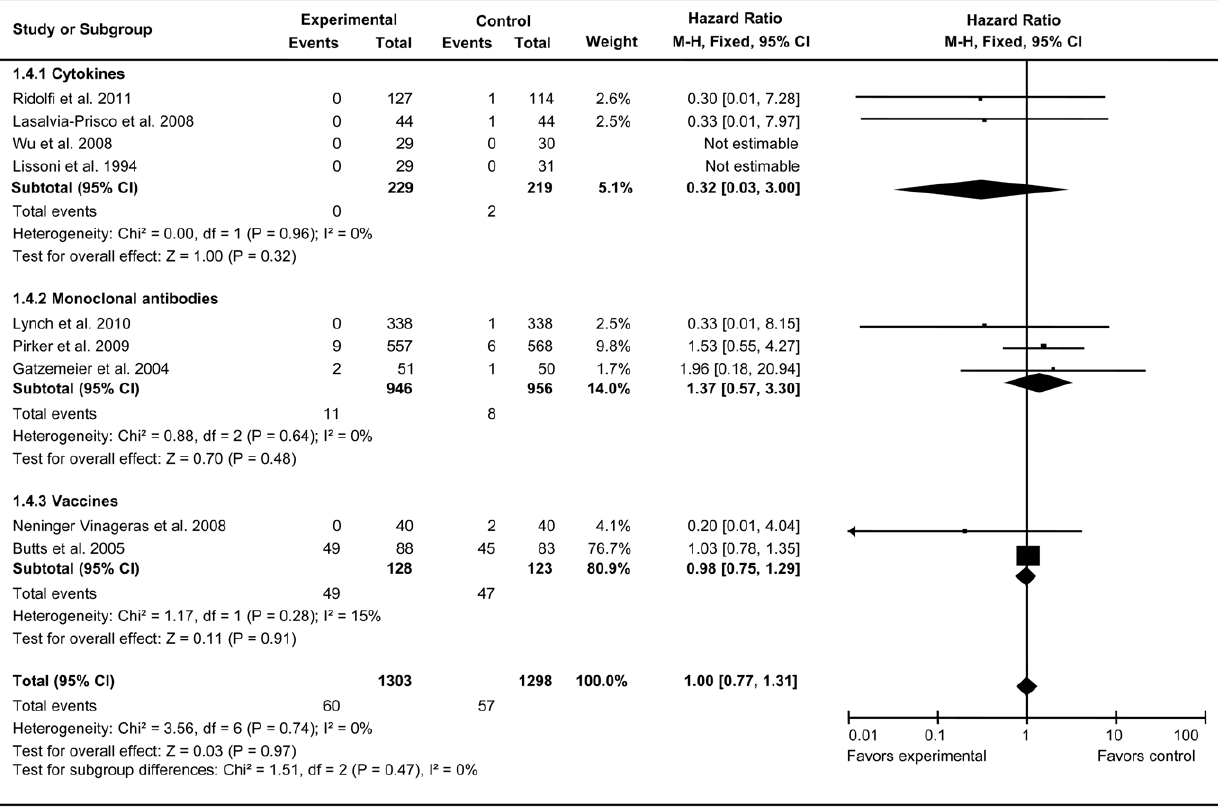
Figure 6. Forest plot of comparison of complete response of 9 included trials (Stage IIIA, IIIB, or IV NSCLC). P values are from P-for- effect modification testing for heterogeneity within or across the groups of regimens. The sizes of data markers are proportional to the number of CR rate events in the trials. CI, confidence interval; HR, hazard ratio.